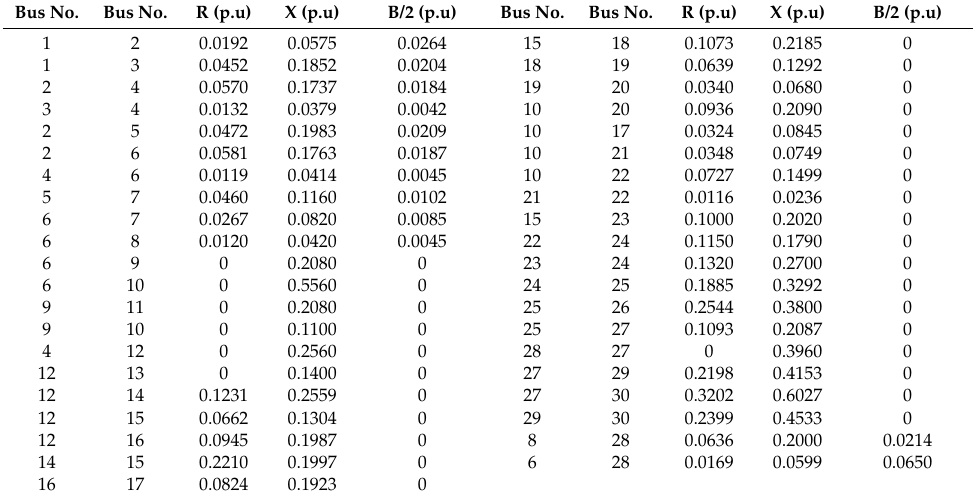
Table A1. Transmission line date of IEEE 30-bus system.